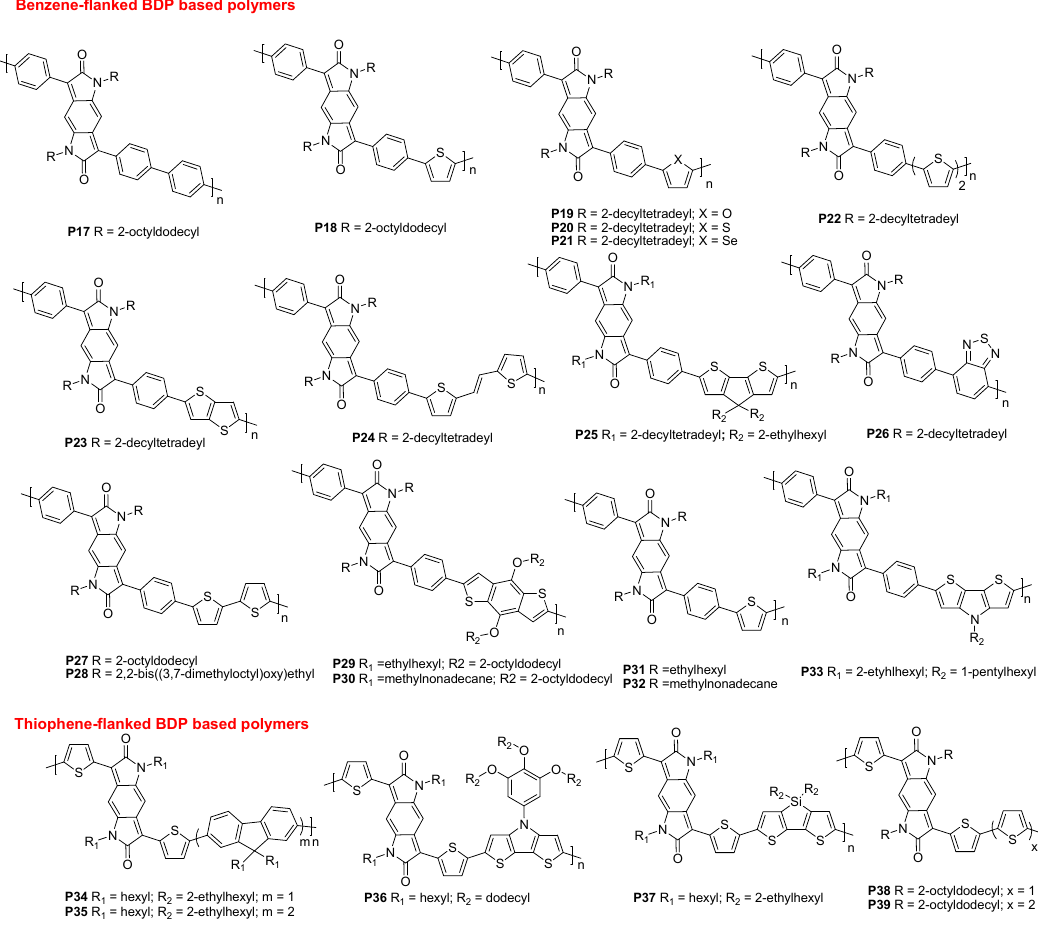
Figure 6. Chemical structure of polymers based on DPP.